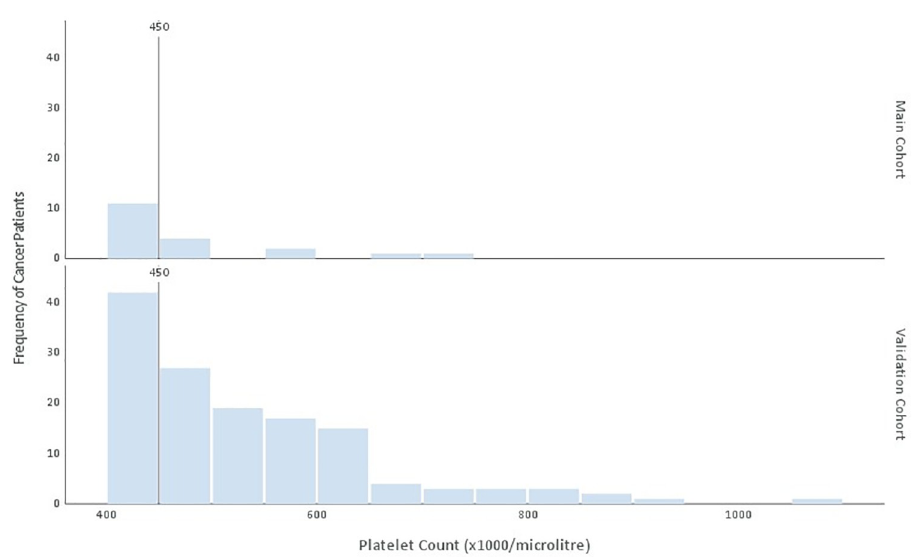
Fig 4. Histogram displaying distribution of platelet count in cancer patients in main and validation cohorts. Vertical line represents 450x10 9 , the upper limit of the reference range for platelet count in many laboratories.